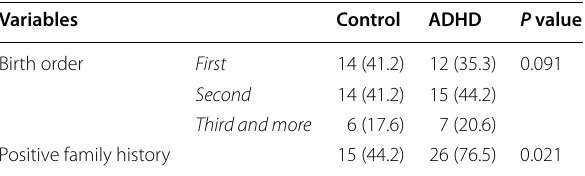
Table 1 Frequency (percentage) of birth order and positive family